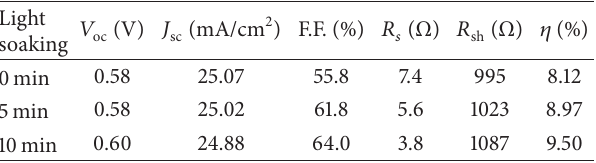
Figure 5: (a) J-V characteristics of ZnS/CIGS heterojunction solar cell with various light soaking times and (b) the IPCE spectrum of CIGS solar cell with efficiency of 9.5%. Table 1: Photovoltaic performance of the AZO/ZnS/CIGS hetero- junction solar cell with various light soaking times, under AM1.5G at 100 mW/cm 2